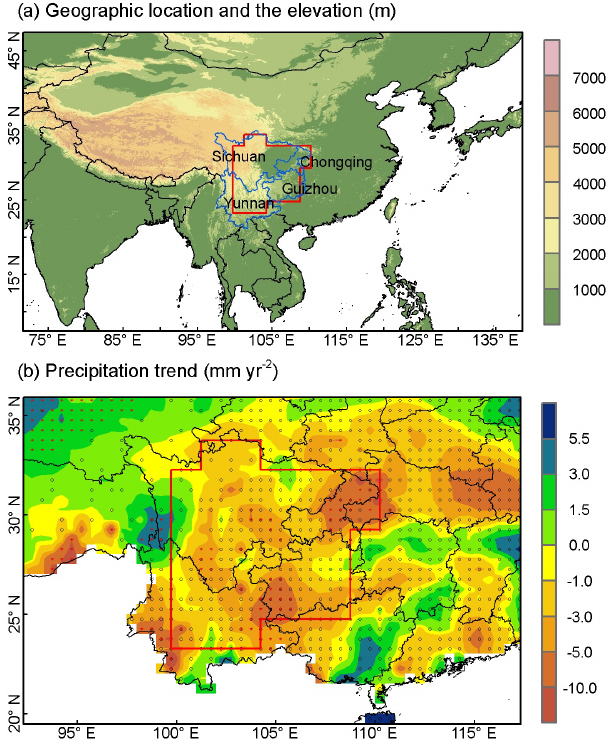
Figure 1. (a) Geographic location of SWC (red box). The blue lines delineate the major provinces/municipalities within SWC. (b) The trend of annual precipitation in SWC from 1979 to 2013 with the CMA precipitation. The circles indicate the 0.5 ◦ grids with at least one rain gauge in 1979. The red dots denote the precipitation trends with significance at the 5%